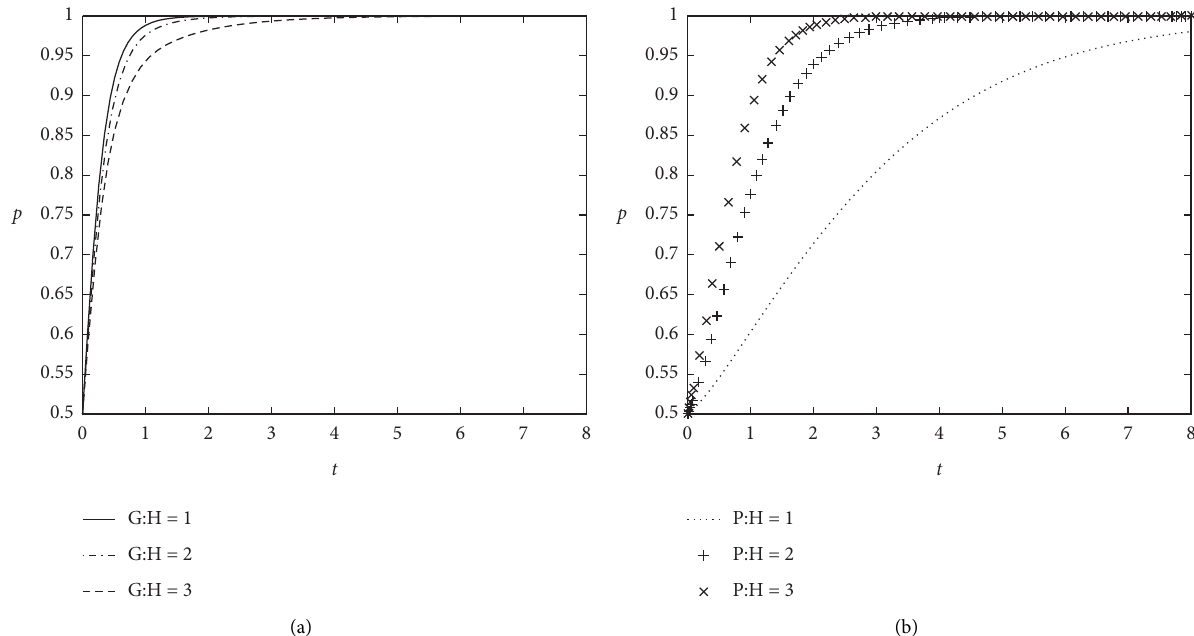
Figure 6: The impact of rewards. Evolutionary behavior of (a) the local government and (b) the public.